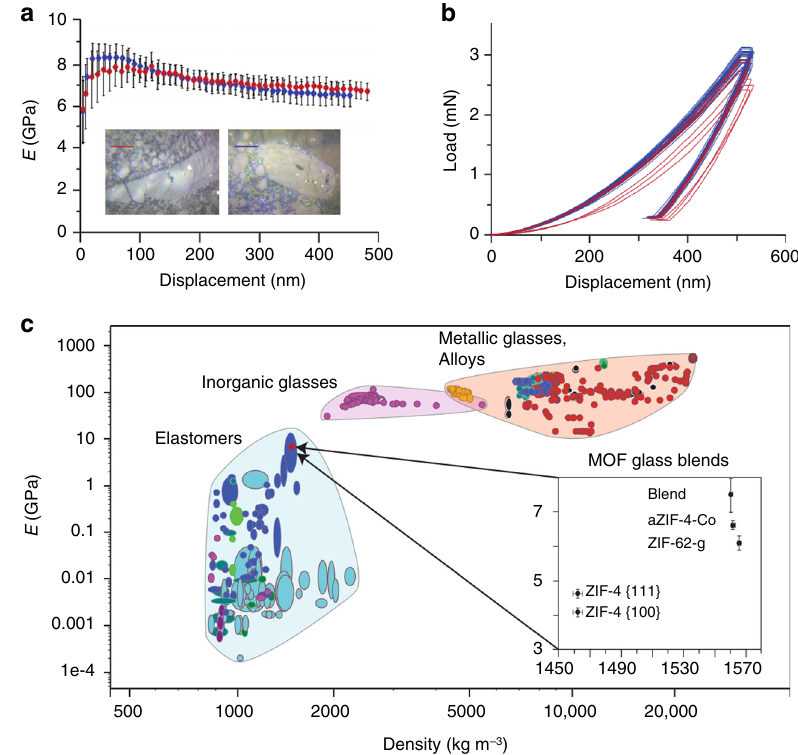
Fig. 6 Mechanical properties. a The Young ’ s modulus, E , as a function of indentation depth for two samples of (ZIF-4-Co) 0.5 (ZIF-62) 0.5 . Error bars represent the standard deviation of 26 measurements for sample 1 (blue) and 8 for sample 2 (red). Inset — optical images of the two samples. Scale bars are 20 μ m. b Load – displacement curves for both samples and c Ashby-style plot of existing alloys, blends and glasses, with the materials here placed